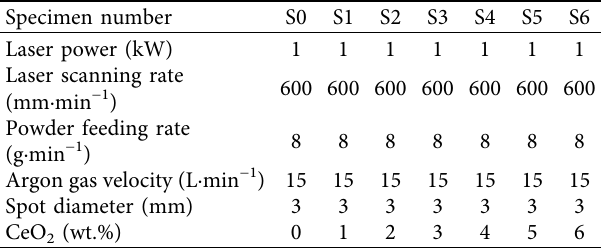
Table 4: Specimen numbers and corresponding laser-cladding process parameters and CeO 2